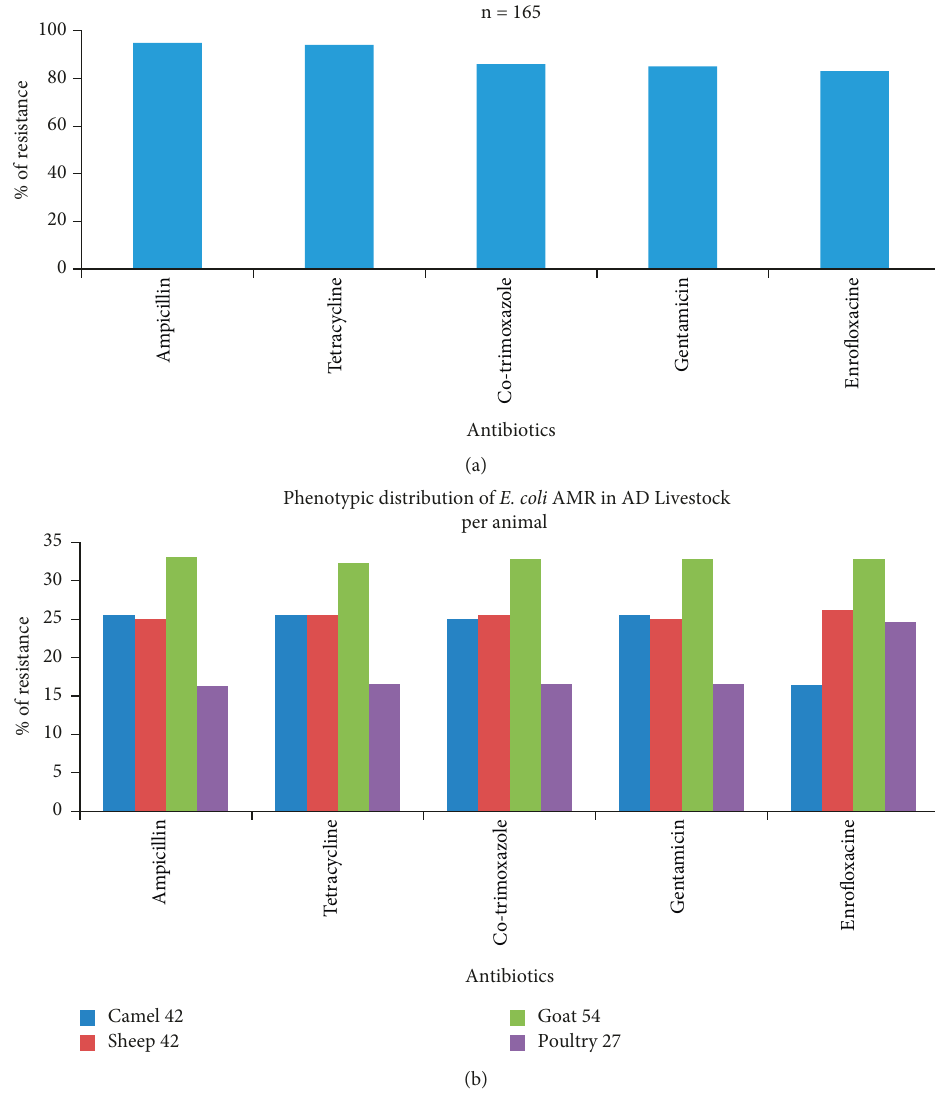
Figure 1: Antimicrobial resistance of E. coli isolates in the Emirate of Abu Dhabi livestock. (a) Per 165 E. coli isolates. (b) Per animal species (camel, sheep, goat, and poultry). A total number of animals are